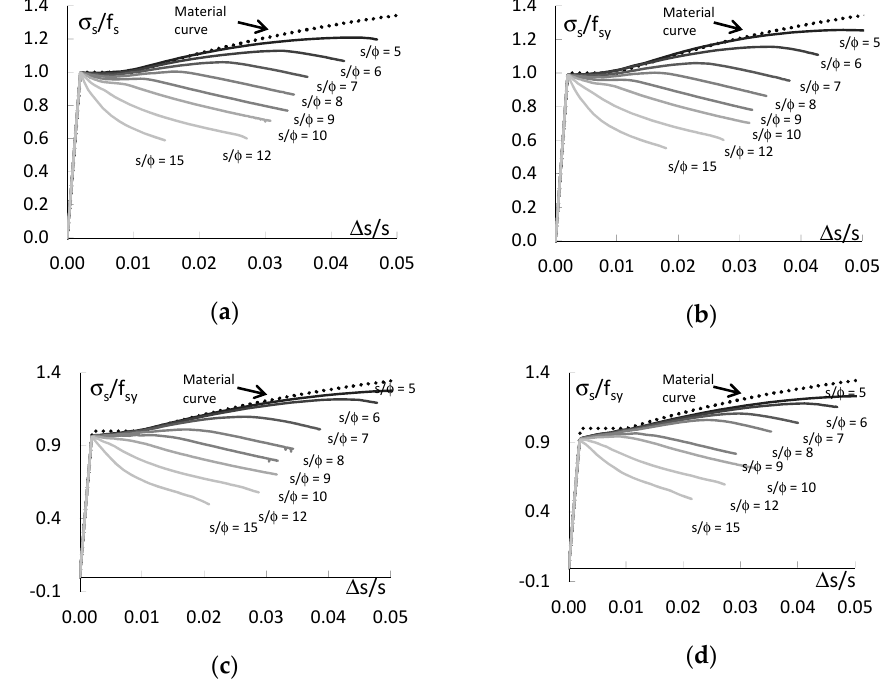
Figure 6. Normalized stress—strain curve for ND bars: ( a ) e/ ϕ = 0.05, ( b ) e/ ϕ =0.10, ( c ) e/ ϕ = 0.25 and ( d ) e/ ϕ = 0.50.